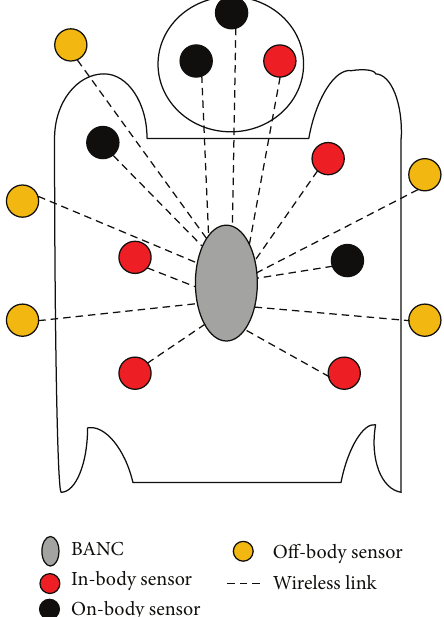
Figure 1: Human body covered with various wireless biomedical